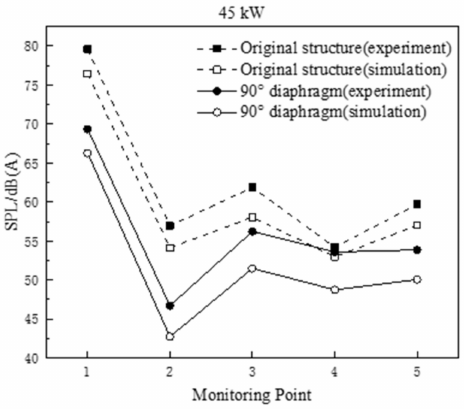
Figure 17. Surface sound pressure cloud image of 120 ◦ structure.